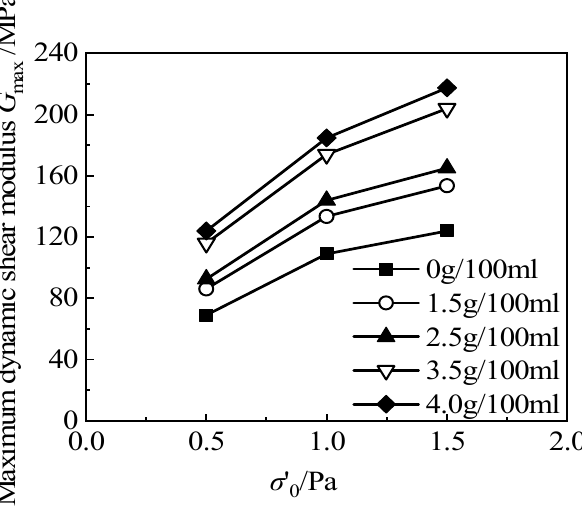
Figure 20. The relationship between G max and σ ’ 0/ Pa, with different cement contents. In 1970, Seed [47] established an empirical formula for calculating the maximum dynamic shear modulus, G max , of sand: